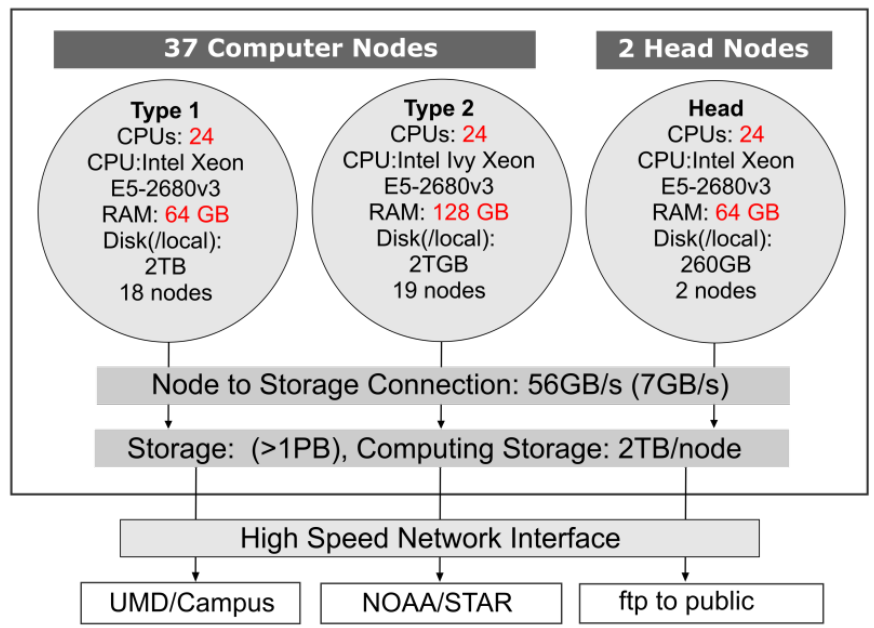
Figure A1. Supercomputer Configuration at the University of Maryland, Earth System Science Interdisciplinary Center (UMD ESSIC).